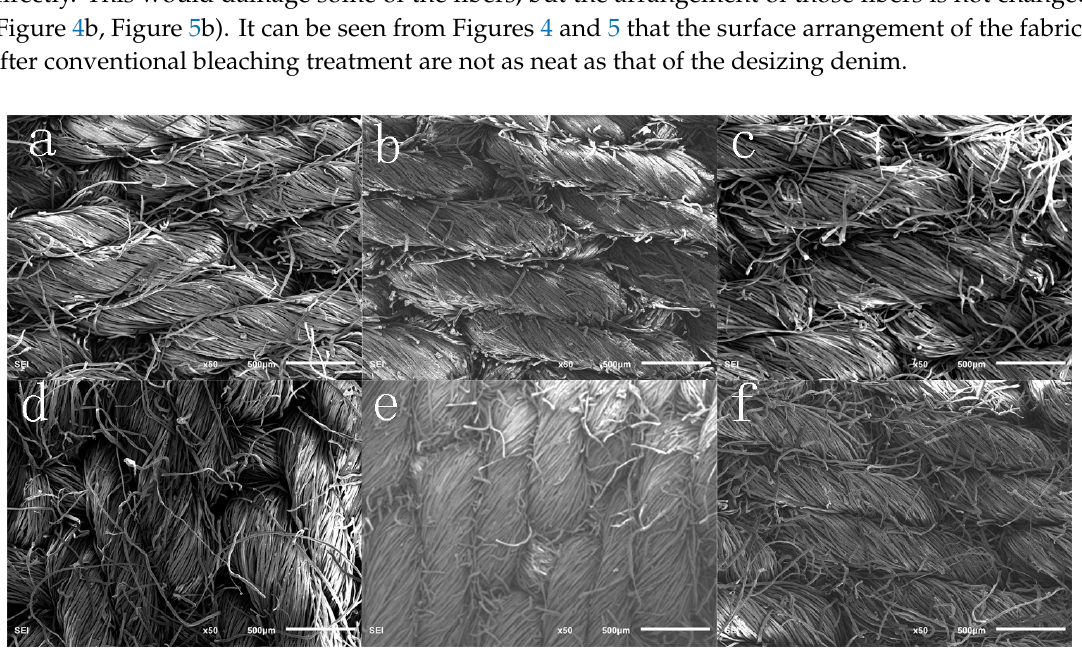
Figure 4. SEM pictures of different kapok/cotton samples (×50): a Desized, b laser bleaching, c enzyme bleaching, d NaClO bleaching, e KMnO 4 bleaching, f H 2 O 2 bleaching. 3.6.2. Study of fiber surface In order to investigate the changes of fibers, the SEM images with higher magnification are observed, as shown in Figure 5 and Figure 6. Apparently, the surfaces of the fibers are attached to dyes (Figure 5 ( a ), Figure 6 ( a )). It can be seen from Figure 5 ( b ) and Figure 6 ( b ) that the surface of the outer fibers of denim fabrics after laser bleaching were damaged, and some fibers were broken. Compared with Figure 5 ( b ) and Figure 6 ( b ), it can be found that after etching, the fibers of fabric 1 only have holes on the surface, and the structure has not been damaged. However, for fabric 2, it can be seen that the interior of the fibers is hollow, and the structure has been damaged.